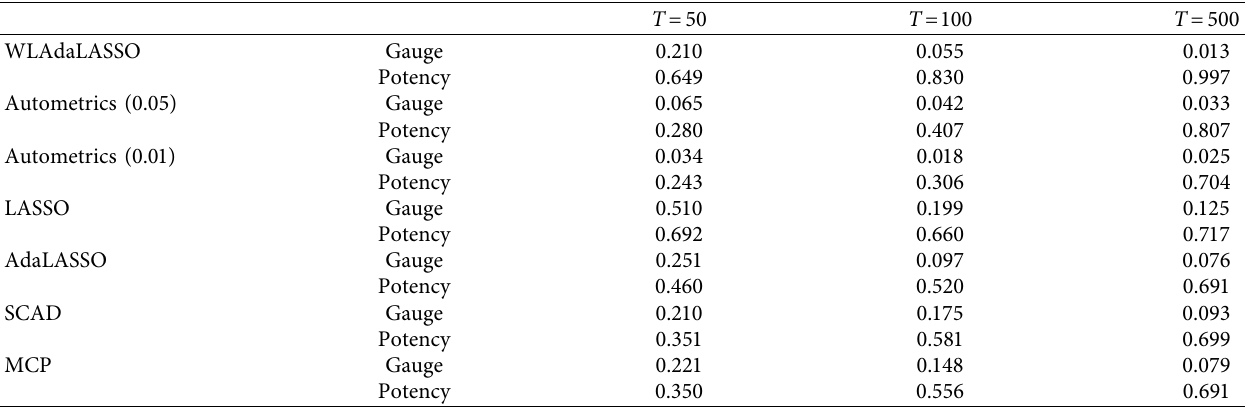
Table 2: Simulated result with ϕ equal to 0.5.